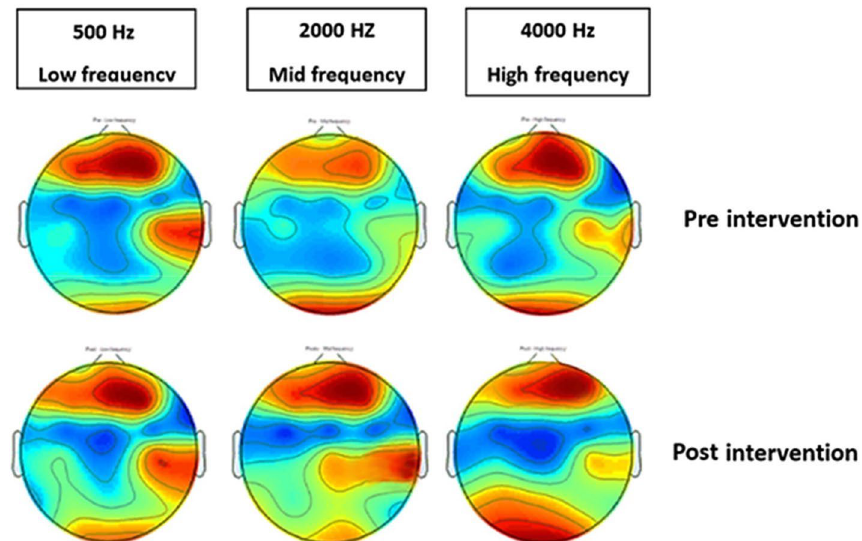
Fig. 4 The graphic map of ASSR 40-Hz amplitude changes after tinnitus management with binaural beat stimuli at three carrier